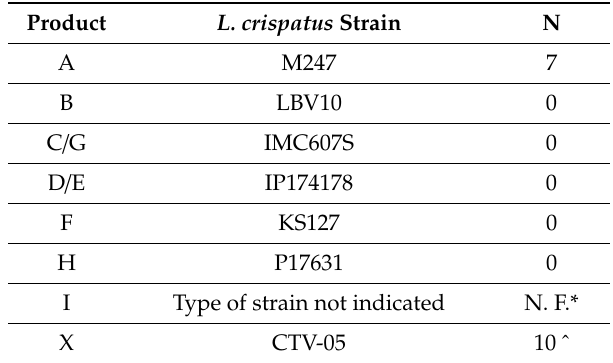
Table 4. Number of documents found on PubMed for the strains indicated in the nine products analyzed and those found on strain CTV-05 (product X, not